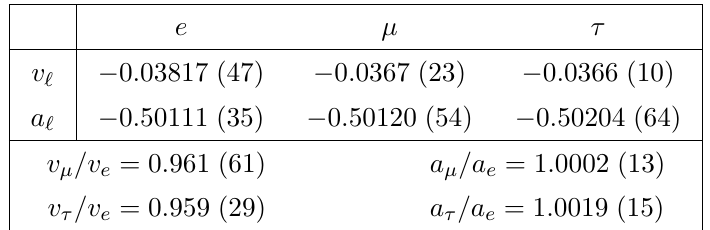
Table 10 . Vector and axial-vector Z couplings from the measured values of the leptonic Z decay widths, left-right and forward-backward asymmetries of the (cid:12)nal lepton ‘ (cid:0) (from PDG